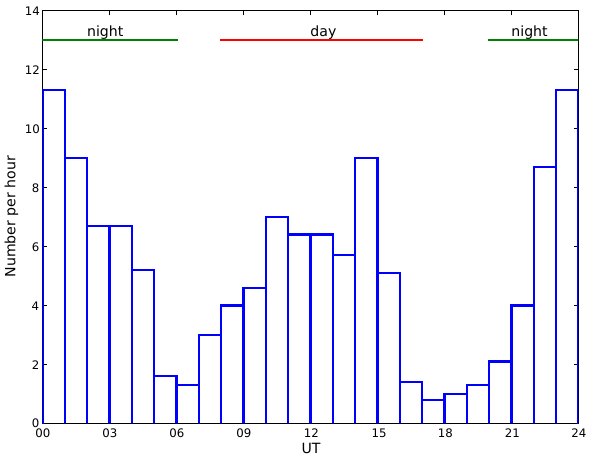
Figure 1: Event incidence over a year (average of 1990-2)